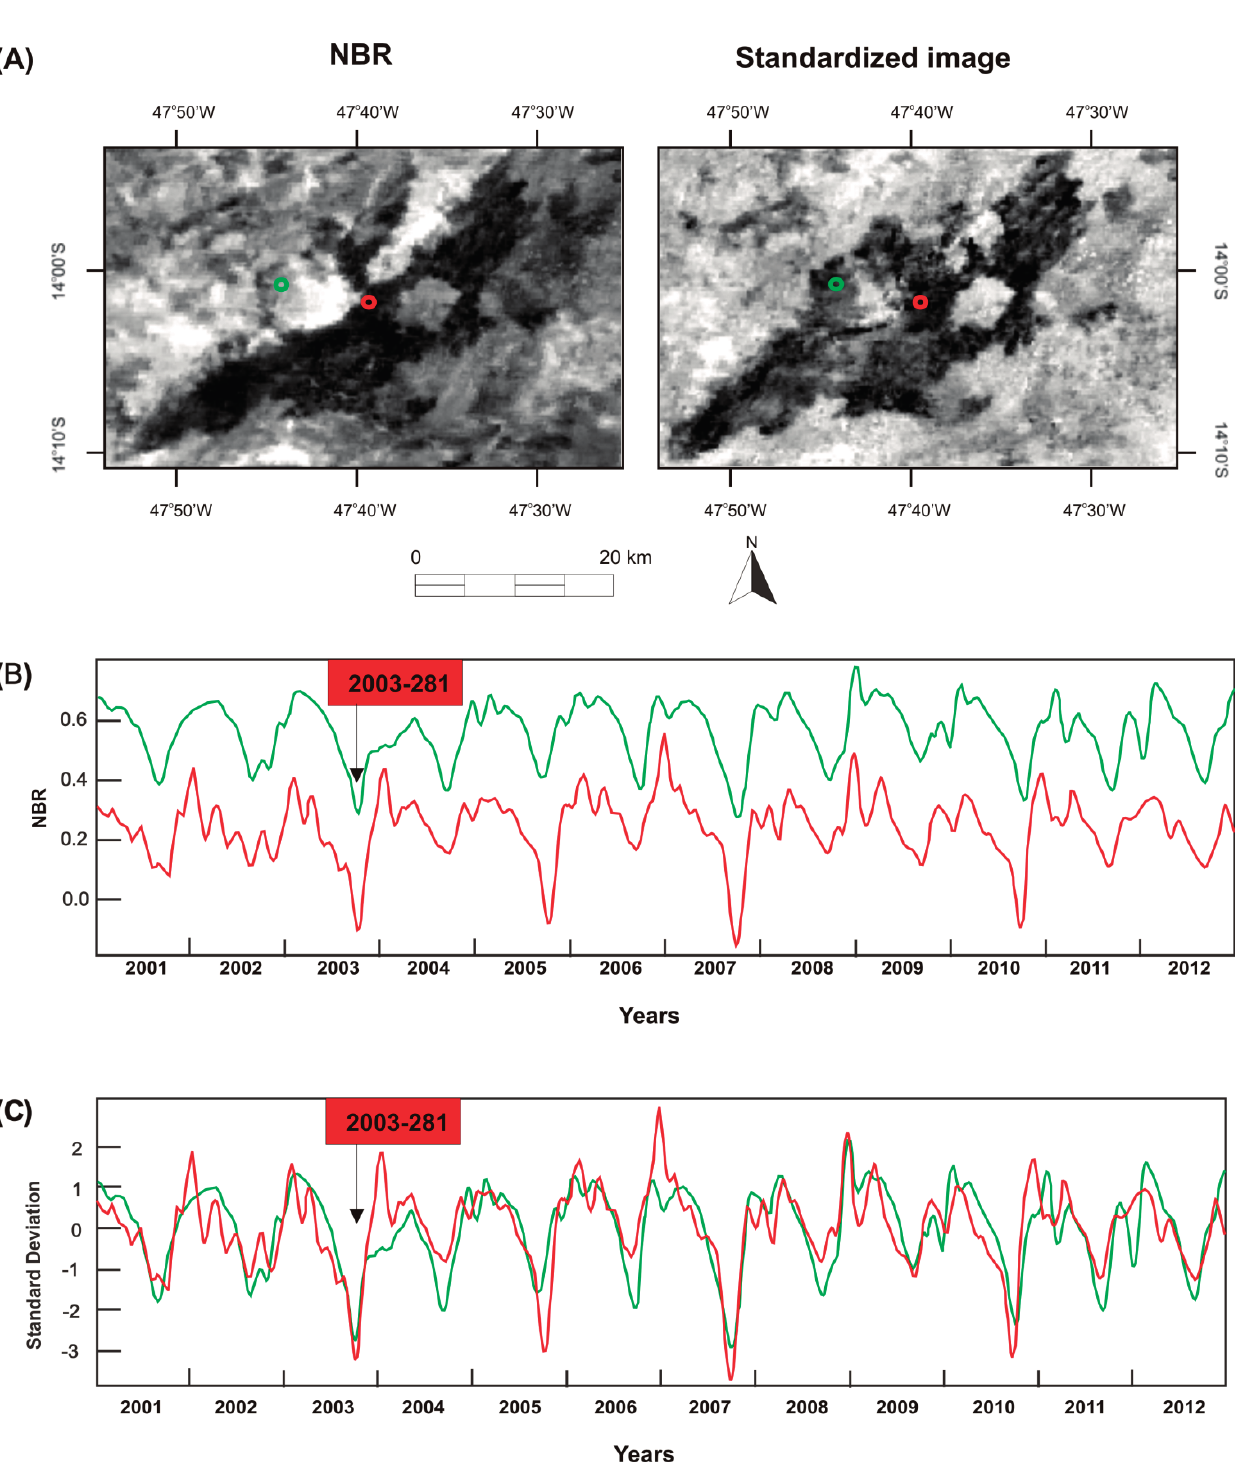
Figure 12. Comparison between the NBR and NBR standardized data: ( A ) NBR-MODIS composite image (Julian day 281–2003) and its respective standardized image, ( B ) NBR temporal curves for the savanna (red point) and Closed Savanna Woodland (green point), and ( C ) NBR standardized temporal curves for the same